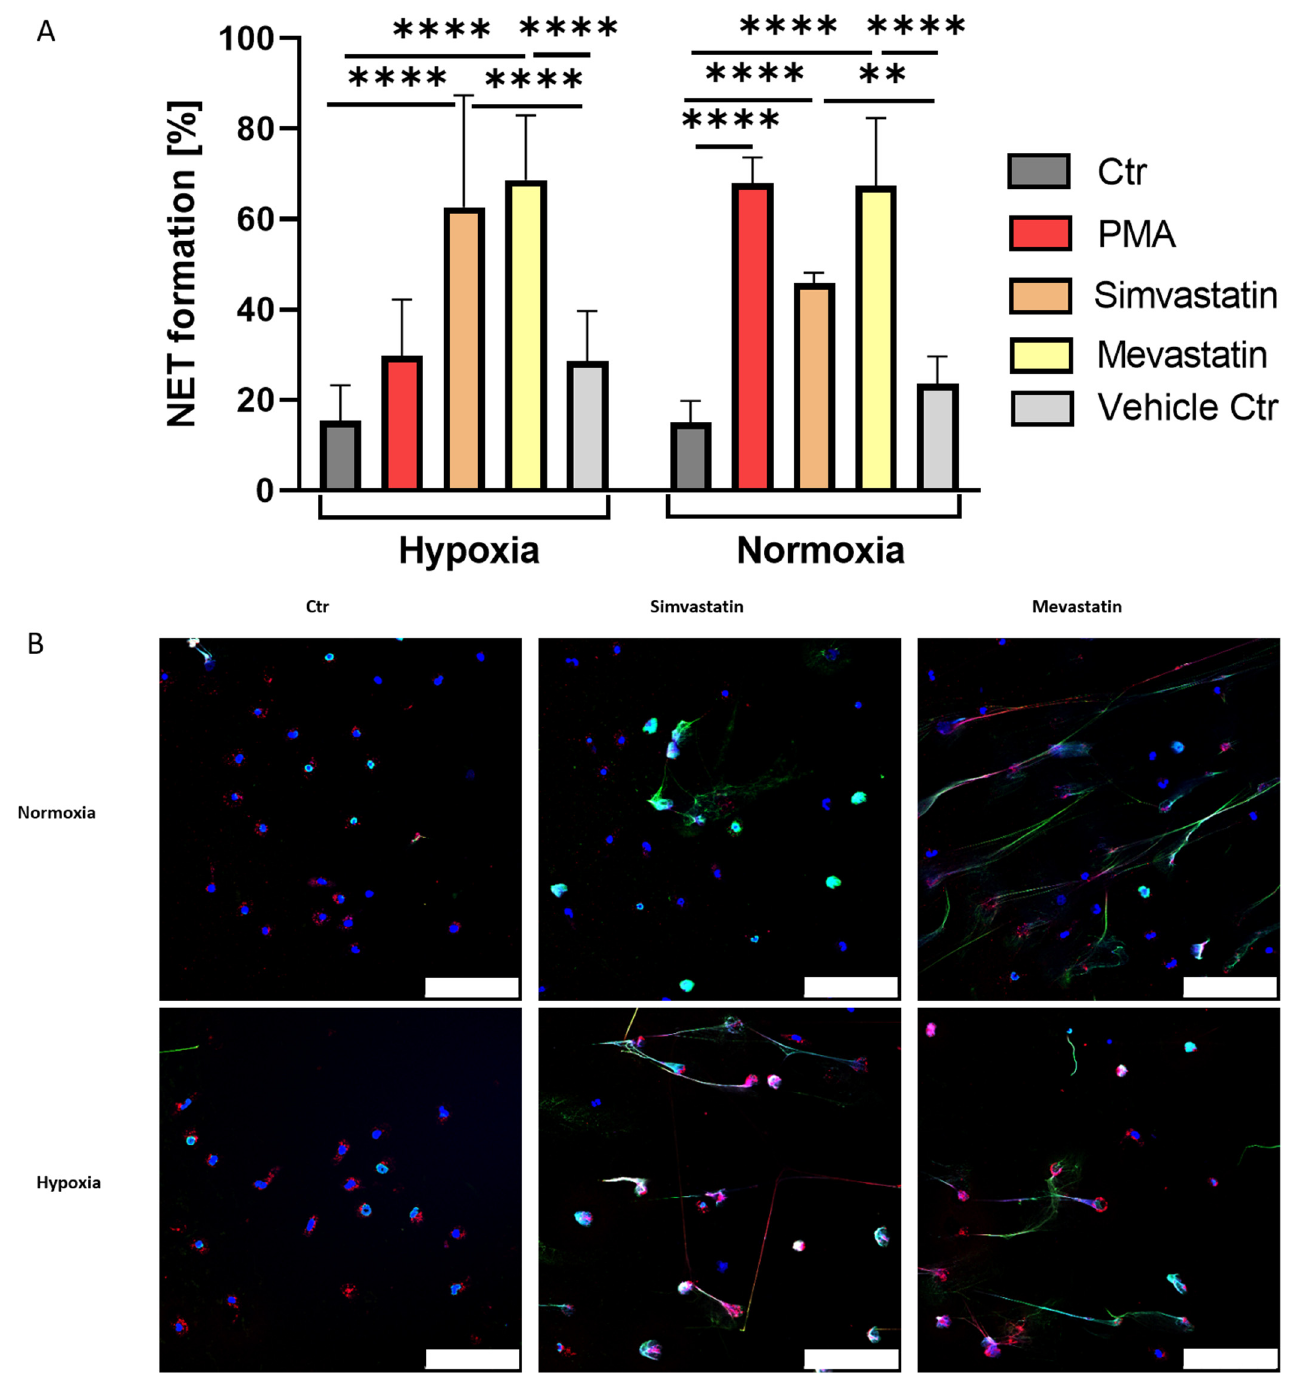
Figure 4. ( A ): Simvastatin and Mevastatin strongly induce NET formation in human neutrophils under hypoxia and normoxia. PMA showed the already described oxygen dependency, while both statins did not differ significantly between the altering oxygen conditions. Significance was analyzed via 1-way ANOVA with multiple comparisons. ( B ): Representative immune fluorescence images of statin-induced NET formation under hypoxia and normoxia, as well as respective negative controls. Both statins showed a similar phenotype of long distinct NET fibers under both oxygen conditions. In addition, both stimuli showed strong positive staining for myeloperoxidase (MPO). Blue: DAPI, green: DNA/Histone1 complex, red: MPO. Scale bars: 100 µ m. N = 3. (** p < 0.01, **** p <